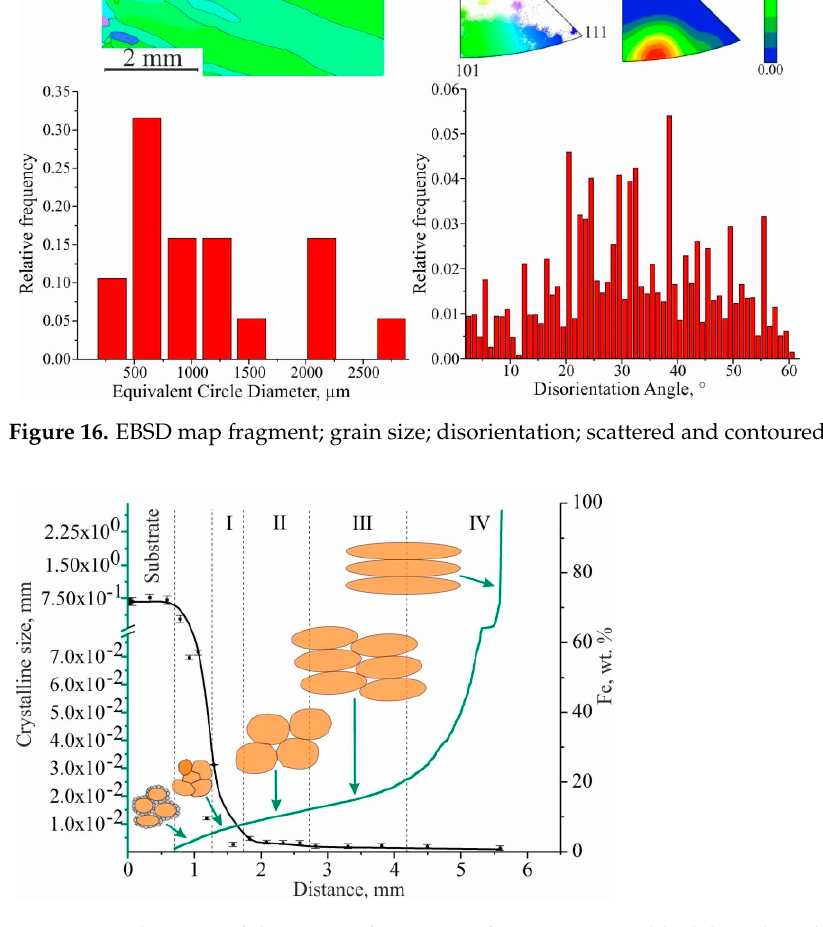
Figure 16. EBSD map fragment; grain size; disorientation; scattered and contoured IPFs for IV area.